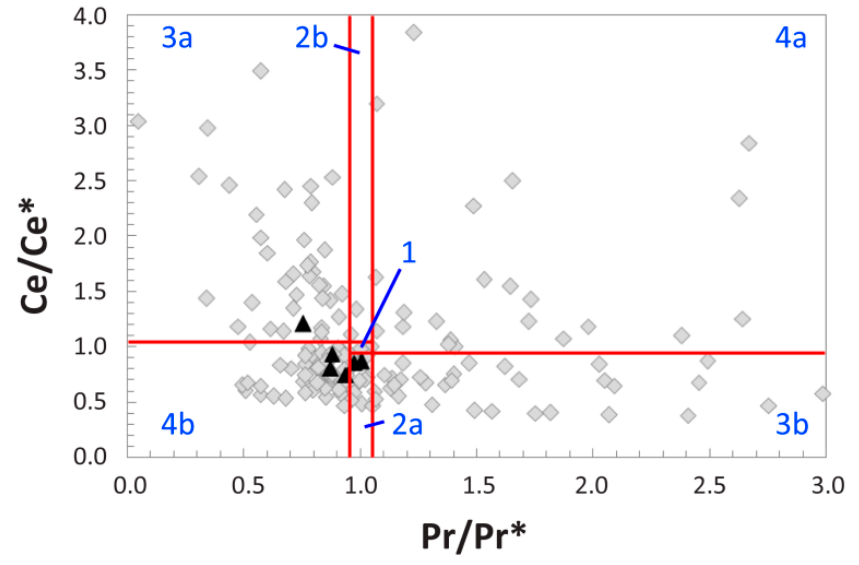
Figure 8. (Ce/Ce*) N vs. (Pr/Pr*) N plot (after [66]) of five-point averages along the transect across the cortex of MOR 1125 recorded by LA-ICPMS. Separate fields (labeled by blue text) are as follows: 1, neither Ce nor La anomaly; 2a, no Ce and positive La anomaly; 2b, no Ce and negative La anomaly; 3a, positive Ce and negative La anomaly; 3b, negative Ce and positive La anomaly; 4a, negative Ce and negative La anomaly; 4b, positive Ce and positive La anomaly. Measurements from the outer 1 mm of the external cortex are plotted as black triangles, and all measurements from deeper within the bone are plotted as grey diamonds. (Ce/Ce*) N and (Pr/Pr*) N anomalies, comparing observed (Ce, Pr) versus expected (Ce*, Pr*) concentrations of each element, are calculated as in the Materials and Methods section of the